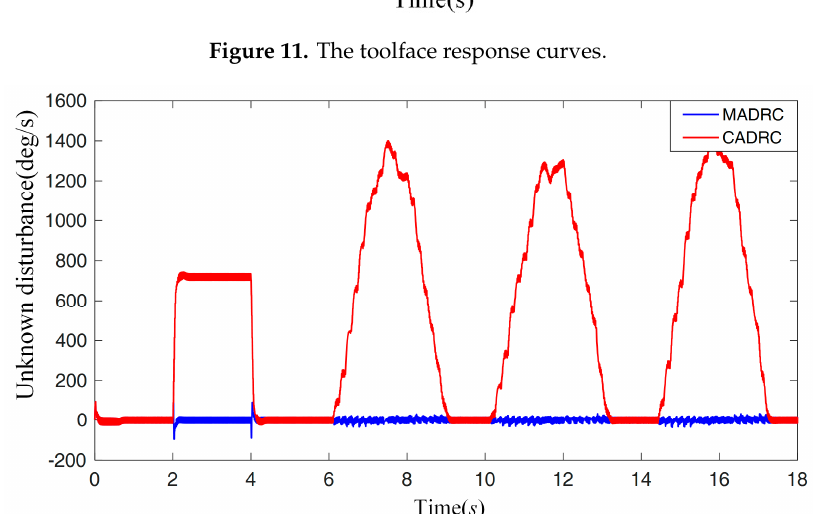
Figure 12. The ESO estimated disturbances of CADRC and MADRC in the toolface loop. The DPRSS is operated in harsh drilling conditions, the parameter uncertainties in Equation (16) and the disturbance rejection performance in the presence of various disturbances need to be